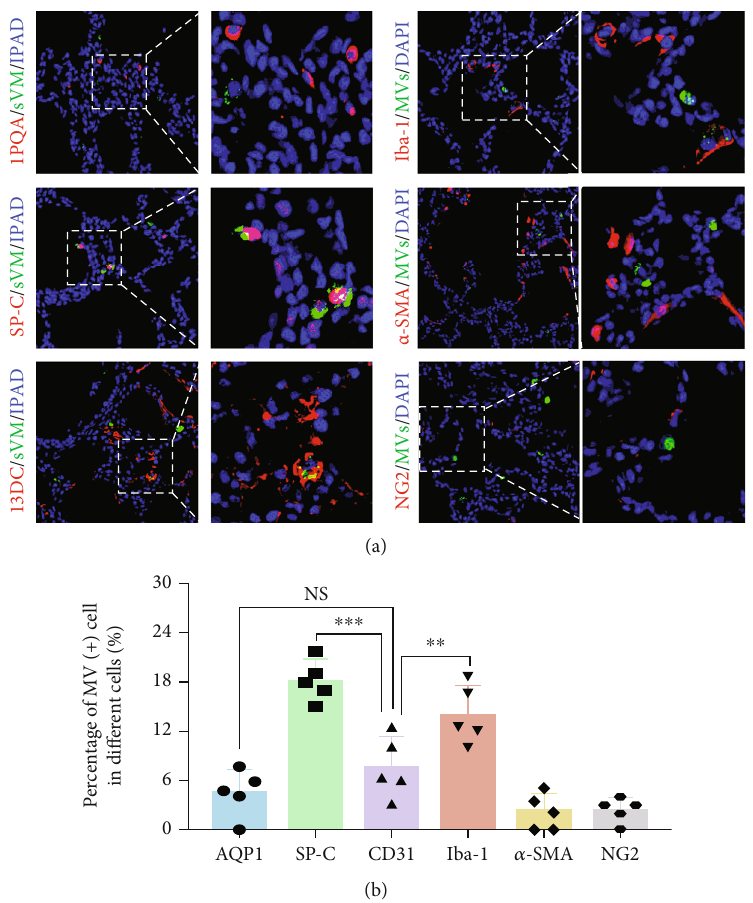
Figure 6: Location of the transtracheally delivered MVs according to the lung tissue cell types. (a) Representative immuno fl uorescence images of donor MVs and host lung cells staining at 48 hours after MV administration. The MVs were prestained with DiO dye (green). The nuclei were labeled with DAPI (blue); the AT1, AT2, vascular endothelial cells, total macrophages, vascular smooth muscle cells, and vascular pericytes were stained with AQP1, SP-C, CD31, Iba-1, α -SMA, and NG2 (red), respectively. (b) The rate of donor MV incorporation into each type of host lung cells ( N = 5 , ANOVA, NS: not signi fi cant, ∗∗ P < 0 : 01 and ∗∗∗ P < 0 : 001